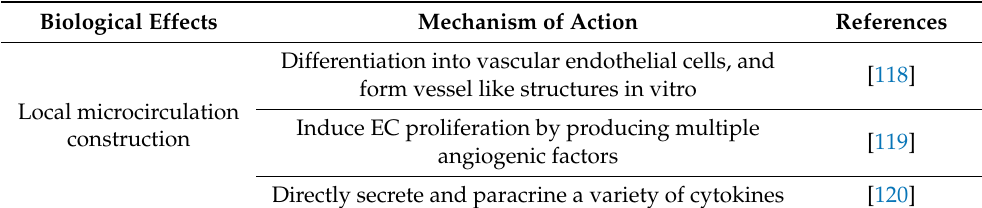
Table 3. The mechanism of action of MSC transplantation in the treatment of